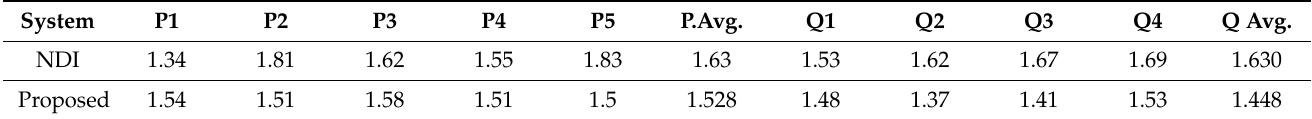
Table 5. Performances of NDI vs. Proposed System on the head phantoms .